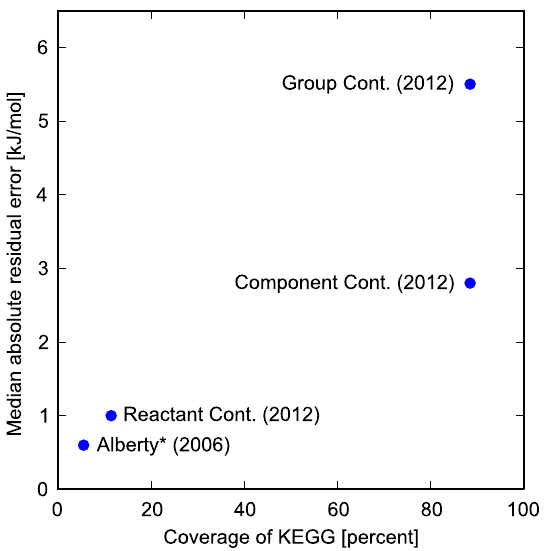
Figure 1. The development of Gibbs energy estimation frameworks. The coverage is calculated as the percent of the relevant reactions in the KEGG database (i.e. reactions that have full chemical descriptions and are chemically balanced). The median residual (in absolute values) is calculated using leave-one-out cross-validation over the set of reactions that are within the scope of each method. Note that the reason component contribution has a higher median absolute residual than RC is only due to its higher coverage of reactions (for reactions covered by RC, the component contribution method gives the exact same predictions). *The residual value for Alberty’s method is not based on cross-validation since it is a result of manual curation of multiple data sources – a process that we cannot readily repeat.